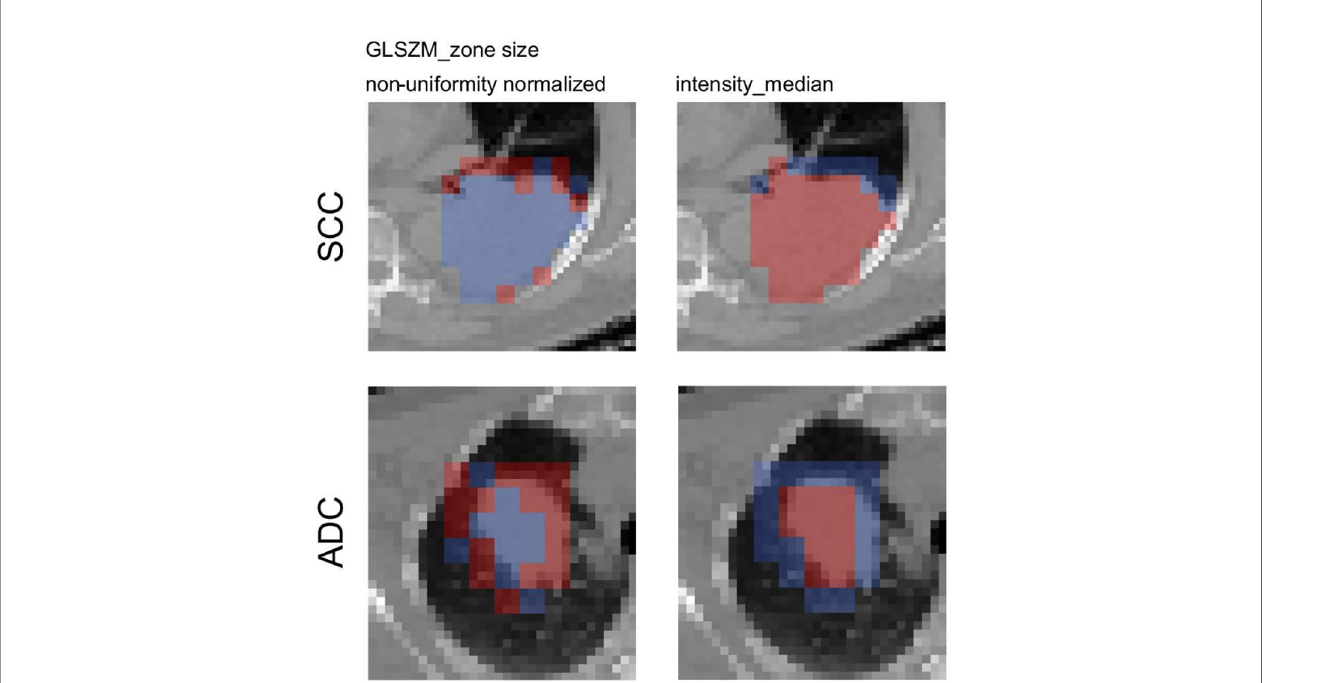
FIGURE 5 | Axial slices of the feature activation maps overlaid with the corresponding CT scan of a squamous cell carcinoma patient (SCC) and an adenocarcioma patient (ADC) from the validation cohort. Activated (red) patches had feature values larger than the median feature value from the training, whereas non-activated (blue) patches had feature values smaller than the median. The texture feature was activated mostly in the rim region whereas the intensity_median was activated mostly in the tumor